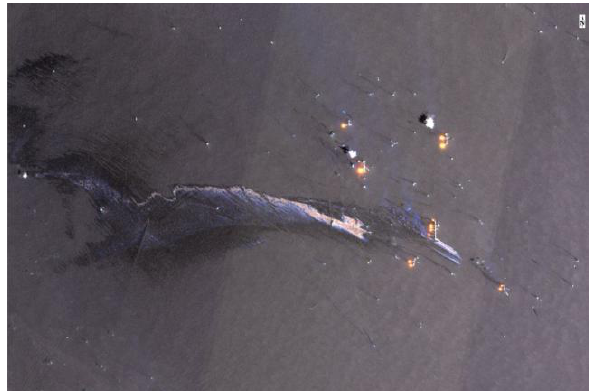
Figure 5b. False colour image of field in Fig; 5a. Channels are SWIR2, SWIR1 and NIR.